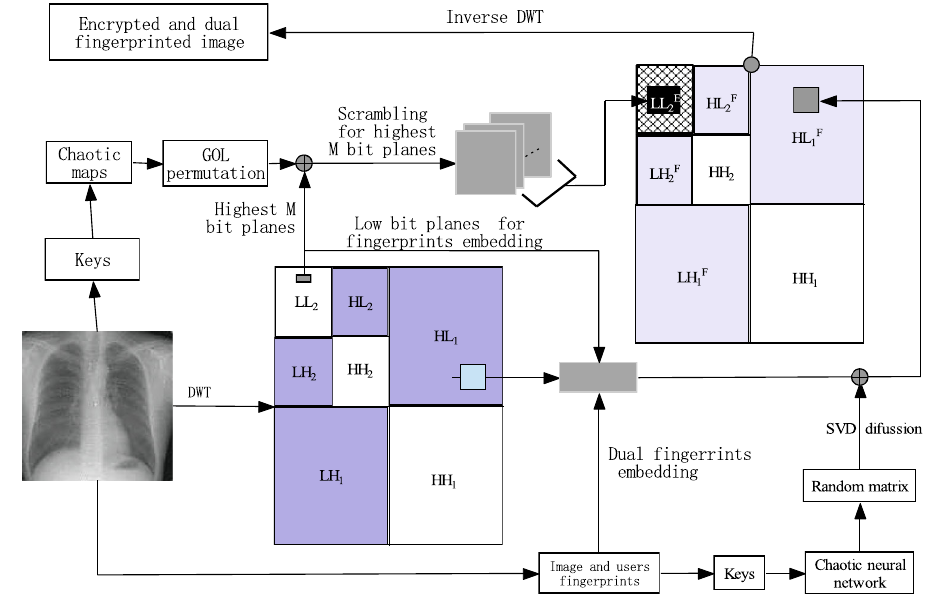
Fig. 1 The proposed privacy protection